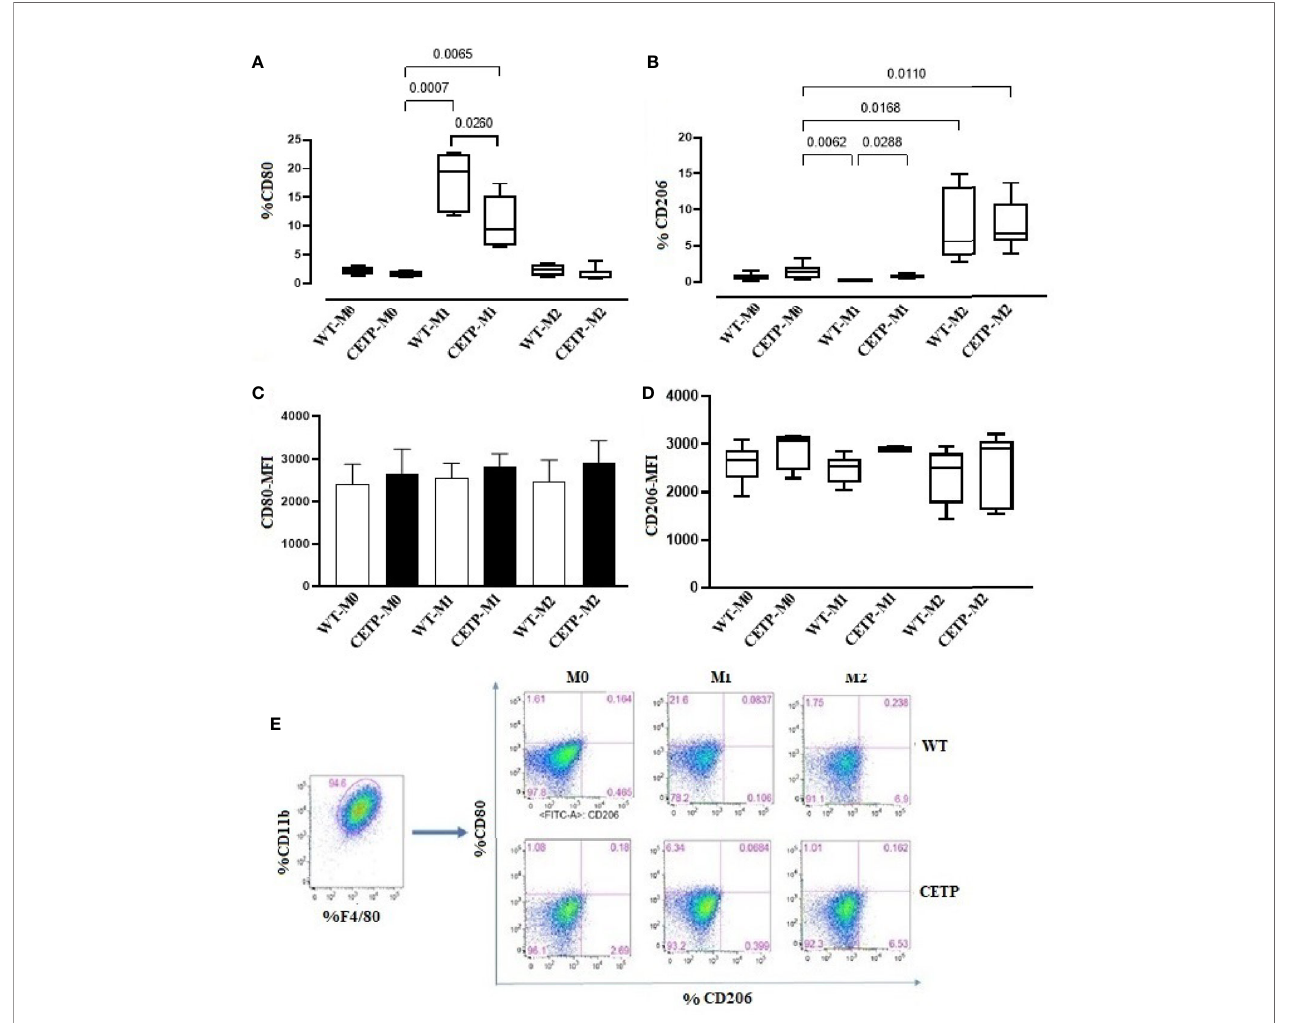
FIGURE 4 | Expression of cell surface markers associated with M1 (CD80) and M2 (CD206) from bone marrow-derived macrophages of WT and huCETP Tg mice. Expression of CD80 (A) , CD206 (B) , mean fl uorescence intensity (MFI) of CD80 (C) , MFI of CD206 (D) , and representation of the gate strategy (E) . Non-stimulated control cells (M0), stimulated M1 (5 ng/ml of IFN g + 50 ng/ml of LPS) or M2 (10 ng/ml of IL-13 + IL-4) for 24 h. Basal fl uorescence was determined using unlabeled cells, and compensation was performed with cells labeled with the respective fl uorochromes on the FACSCanto II cytometer. In total, 100,000 events were analyzed. Values were expressed as mean and standard deviation. Values expressed as median and percentiles 25 and 75 were analyzed by Kruskal – Wallis test with original FDR method of Benjamini and Hochberg post-test. The values expressed as mean and standard deviation were analyzed by ANOVA with two-stage linear step-up procedure of Benjamini, Krieger, and Yekutieli post-test; (n = 3), P <